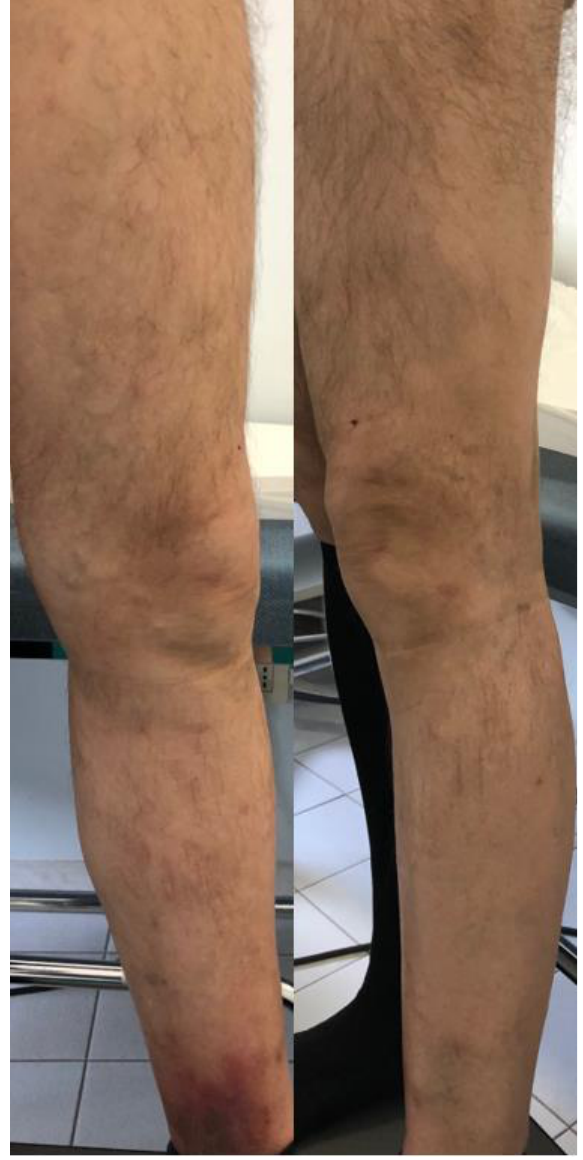
Figure 2. 1 year post-operative photo of the lower left limb treated with radiofrequency ablation of the Great saphenous vein, flebectomies and sclerotherapy of the collateral veins with absence of recurrent or persistent varicosities. Statistical analysis was conducted using the 26 th version of IBM SPSS statistics. The